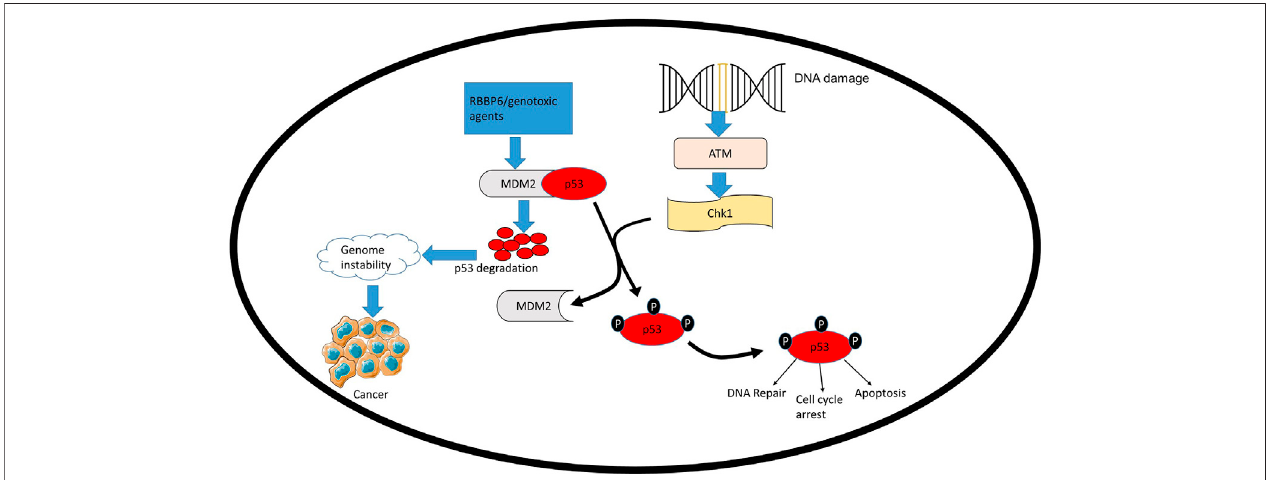
FIGURE3| MDM2regulatesthestabilityofTP53 , thus,in fl uencingitsroleincellhomeostasis.NegativeregulatorsofTP53suchasRBBP6caninteractwithMDM2 and facilitate the ubiquitination and degradation of TP53 by MDM2. Overexpression of MDM2 signi fi cantly delays DNA repair, resulting in damage persisting for longer thus promoting genome instability, which leads to cancer development.